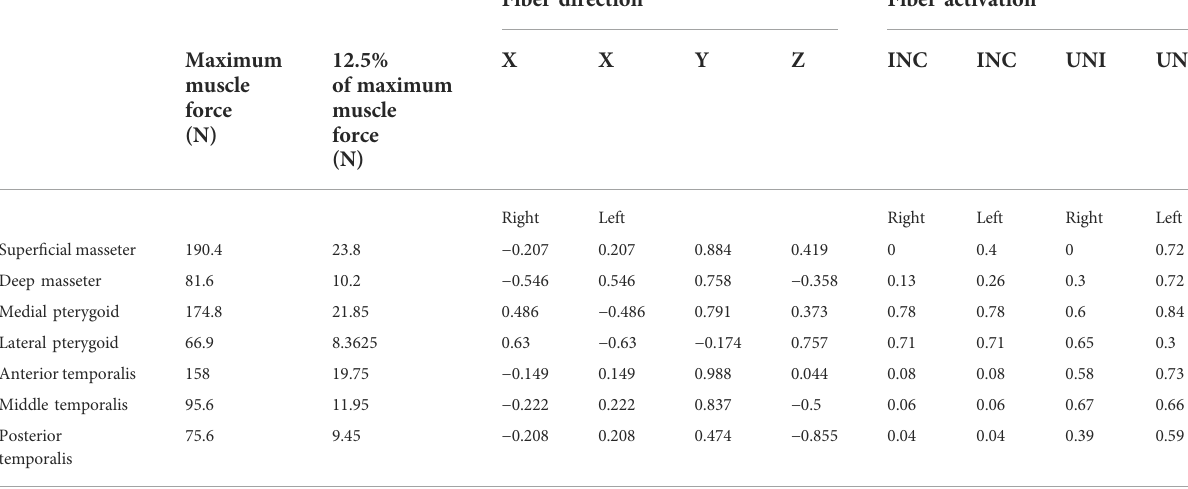
TABLE 1 Maximum Muscle Forces, fi ber direction, and fi ber activation in the biting tasks unilateral (UNI) and incisal (INC)